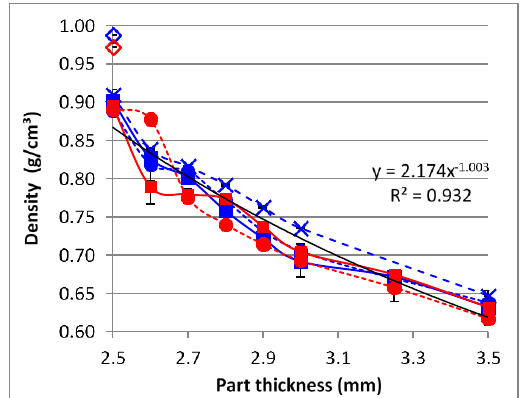
1 1 Figure 5. Dependence of the tensile modulus ( left ) and tensile strength ( right ) on the density of the Figure 5. Dependence of the tensile modulus ( left ) and tensile strength ( right ) on the density of the Figure 4. Dependence of the part density on the nominal part thickness. Legend: PPCell, PPWood. Figure 5. Dependence of the tensile modulus ( left ) and tensile strength ( right ) on the density of the Figure 5. Dependence of the tensile modulus ( left ) and tensile strength ( right ) on the density of the Figure 5. Dependence of the tensile modulus ( left ) and tensile strength ( right ) on the density of the foamed parts. Legend: PPCell, PPWood. Compact samples—  ; samples N03_T60—  , dashed foamed parts. Legend: PPCell, PPWood. Compact samples—  ; samples N03_T60—  , dashed Figure 4. Dependence of the part density on the nominal part thickness. Legend: PPCell, PPWood. Figure 5. Dependence of the tensile modulus ( left ) and tensile strength ( right ) on the density of the Figure 5. Dependence of the tensile modulus ( left ) and tensile strength ( right ) on the density of the Compact samples—  ; samples N03_T60—  , dashed line; samples N06_T60—  , solid lines; foamed parts. Legend: PPCell, PPWood. Compact samples—  ; samples N03_T60—  , dashed foamed parts. Legend: PPCell, PPWood. Compact samples—  ; samples N03_T60—  , dashed foamed parts. Legend: PPCell, PPWood. Compact samples—  ; samples N03_T60—  , dashed Compact samples— , dashed line; samples N06_T60— , solid lines; line; samples N06_T60—  , solid lines; samples N06_T40—  , dotted lines. Error bars show 95% line; samples N06_T60—  , solid lines; samples N06_T40—  , dotted lines. Error bars show 95% foamed parts. Legend: PPCell, PPWood. Compact samples—  ; samples N03_T60—  , dashed foamed parts. Legend: PPCell, PPWood. Compact samples—  ; samples N03_T60—  , dashed samples N06_T40—  , dotted lines. Error bars show 95% confidence interval. If not visible, error line; samples N06_T60—  , solid lines; samples N06_T40—  , dotted lines. Error bars show 95% line; samples N06_T60—  , solid lines; samples N06_T40—  , dotted lines. Error bars show 95% line; samples N06_T60—  , solid lines; samples N06_T40—  , dotted lines. Error bars show 95% confidence interval. If not visible, error bars lie within the size of the used symbol for the respective confidence interval. If not visible, error bars lie within the size of the used symbol for the respective , dotted lines. Error bars show 95% confidence interval. If not visible, error line; samples N06_T60—  , solid lines; samples N06_T40—  , dotted lines. Error bars show 95% line; samples N06_T60—  , solid lines; samples N06_T40—  , dotted lines. Error bars show 95% bars lie within the size of the used symbol for the respective sample. confidence interval. If not visible, error bars lie within the size of the used symbol for the respective confidence interval. If not visible, error bars lie within the size of the used symbol for the respective confidence interval. If not visible, error bars lie within the size of the used symbol for the respective sample. sample. confidence interval. If not visible, error bars lie within the size of the used symbol for the respective confidence interval. If not visible, error bars lie within the size of the used symbol for the respective bars lie within the size of the used symbol for the respective sample. sample. sample. sample. sample.